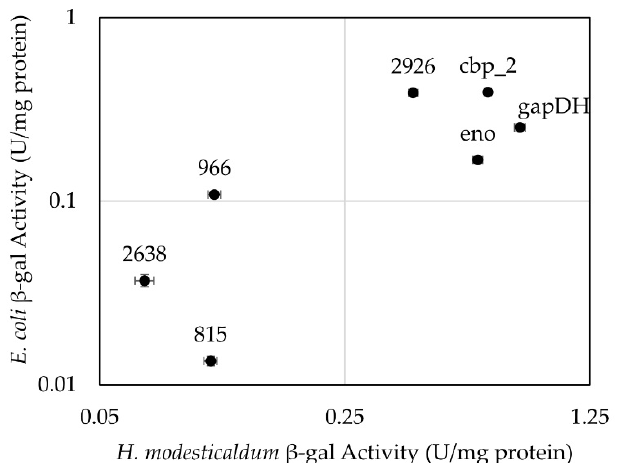
Figure 3. β -gal activities in E. coli and H. modesticaldum transformants plotted on a logarithmic scale. Data points are representative of the average rate of β -gal activity for each promoter. Error bars represent the standard error. (Values listed in Table S4).